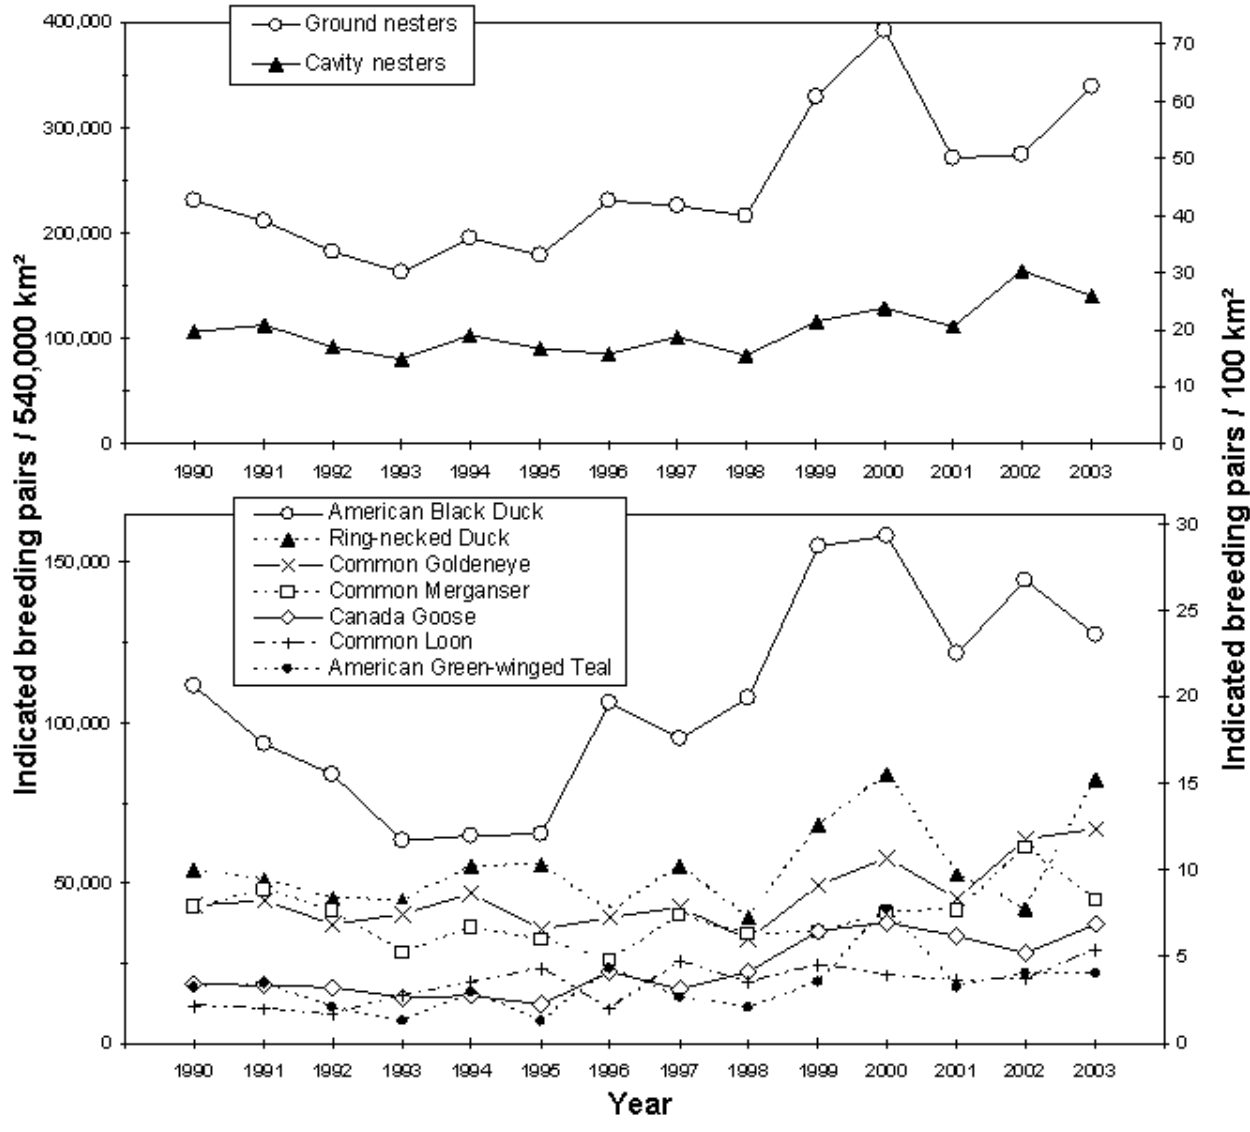
Fig. 2. Population trends of ground nesters and cavity nesters, including the seven most abundant species: American Black Duck, Ring-necked Duck, Common Goldeneye, Common Merganser, and Canada Goose, Common Loon, and American Greed-winged Teal. Population sizes are IBP for the whole study area: values extrapolated from survey plots to the whole 540,000-km² study area; left vertical axis, and IBP/100 km² (right vertical axis) for the 1990–2003 period. Population trends for all species surveyed are available in Bordage et al.